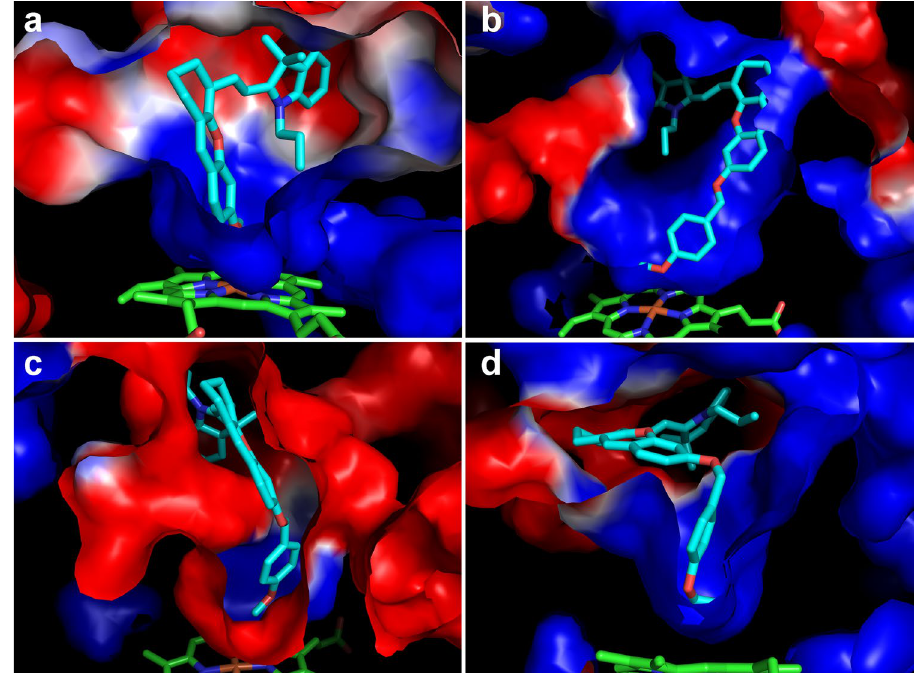
Figure 7. Electrostatic potential surface calculated for the representative conformation of CYP2J2 in complex with M1 ( a ), M2 in the initially extended ( b ) and folded ( c ) conformation, and M3 ( d ). Blue color indicates positive electrostatic potentials, and red color indicates negative electrostatic potentials. This figure was rendered using PyMOL 33 .